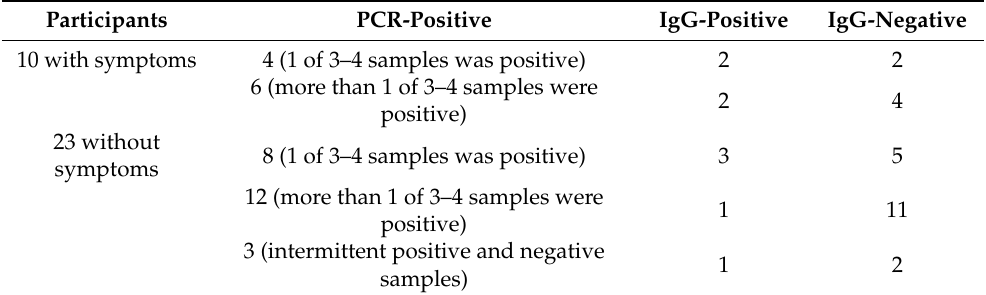
Table 6. Results of samples obtained from participants, sampled and tested 3–4